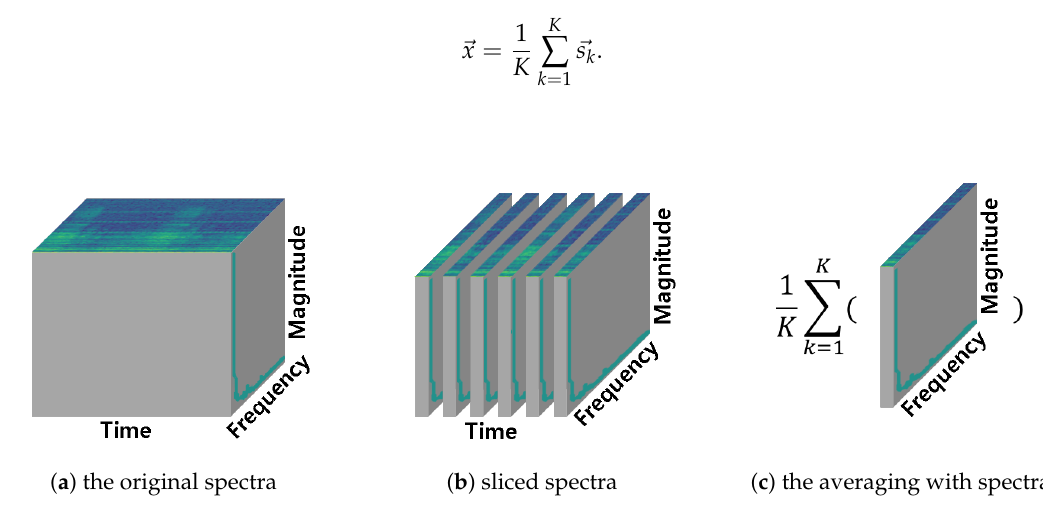
Figure 1. The process for obtaining the average spectrum of spectra. ( a ) original spectra obtained from Short-Time Fourier Transform (STFT) or Mel-Frequency Cepstral Coefficients (MFCC) feature extraction; ( b ) sliced by time axis spectra according to the number of window used in STFT or MFCC feature extraction; ( c ) average of sliced spectra.